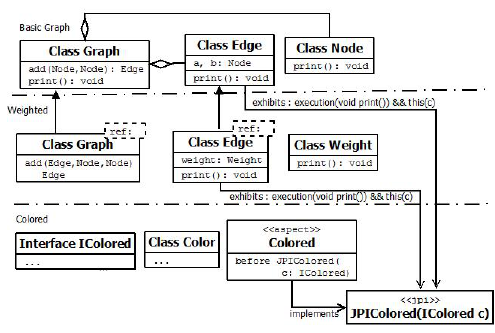
Figure 6: AFM of a graph example